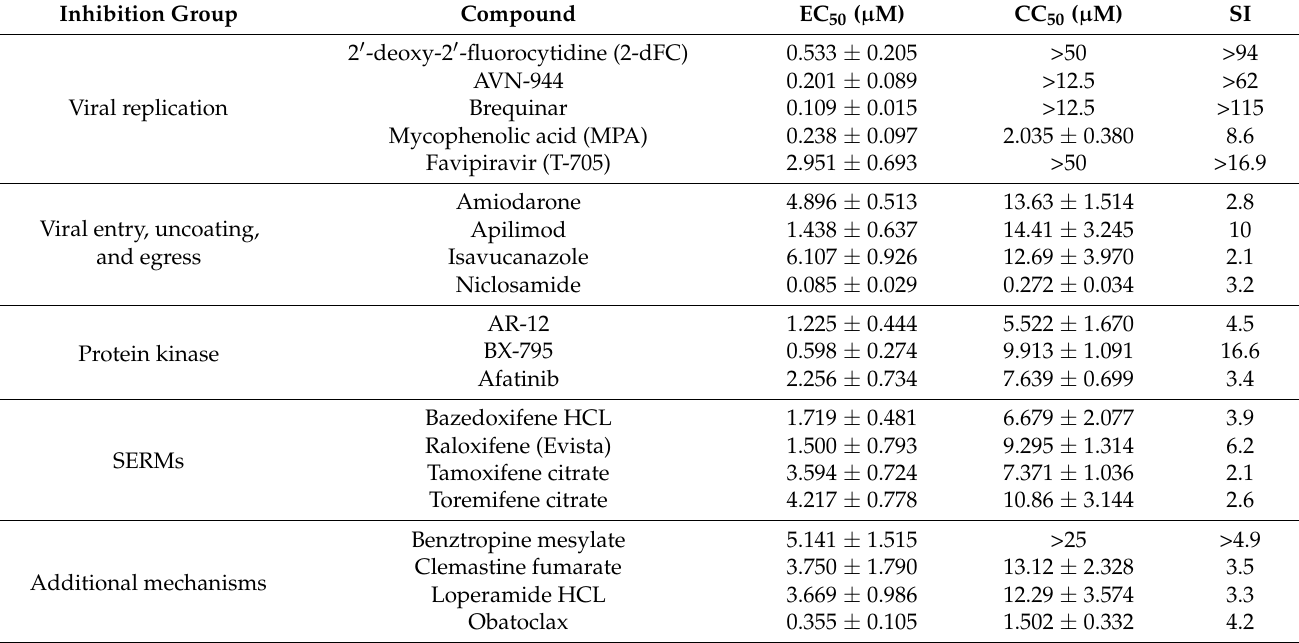
Table 1. 50% effective concentration (EC 50 ), 50% cytotoxic concentration (CC 50 ), and selectivity indices (SI) of select compounds identified by rLUJV/ZsG reporter virus screening assay. Inhibition Group Compound